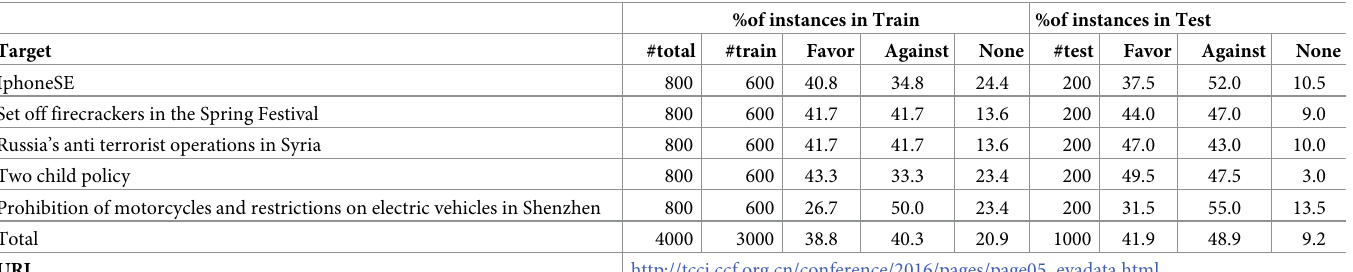
Table 3. NLPCC-ICCPOL-2016 stance